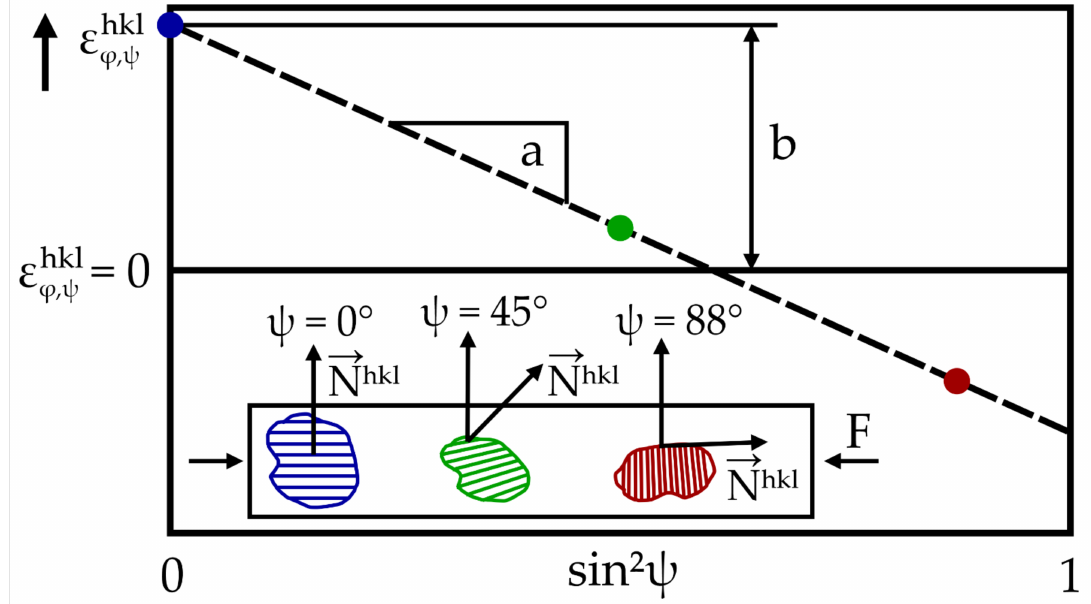
Figure 6. Simplified ε ( sin 2 ψ ) distribution assuming an elastically isotropic or non-textured material in a homogeneous compression stress state (adapted from